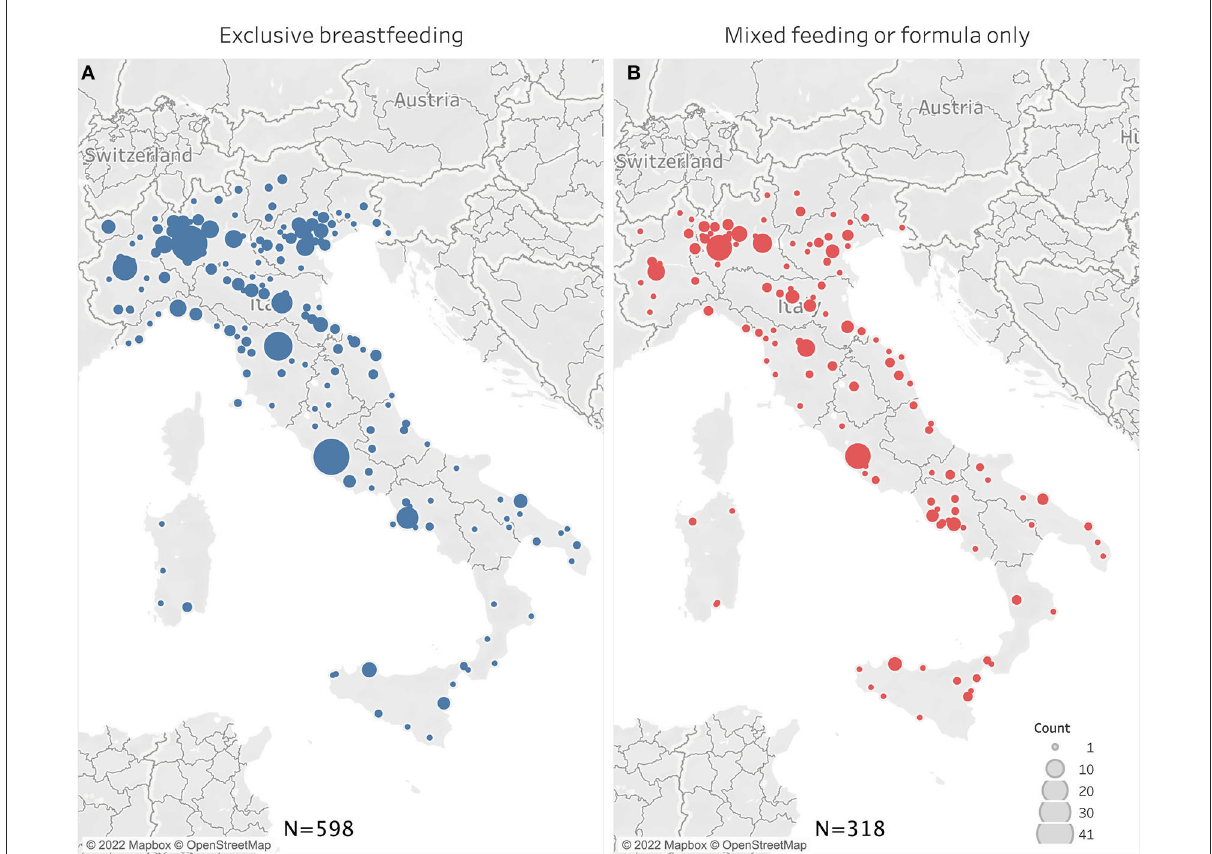
FIGURE1 Geographical distribution of women who reported exclusive breastfeeding (A) or formula/mixed feeding (B) .